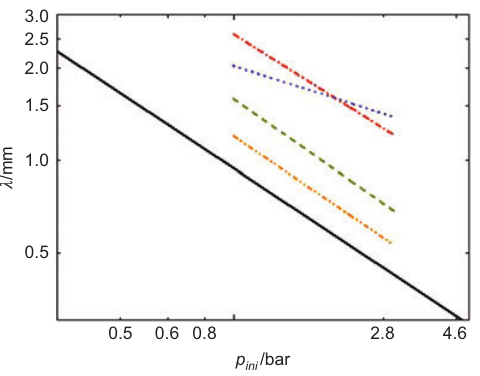
Figure 10 Correlation between initial pressure and mean detonation cell width for stoichiometric and non-stoichiometric ethane/O mixtures at ambient temperatures.